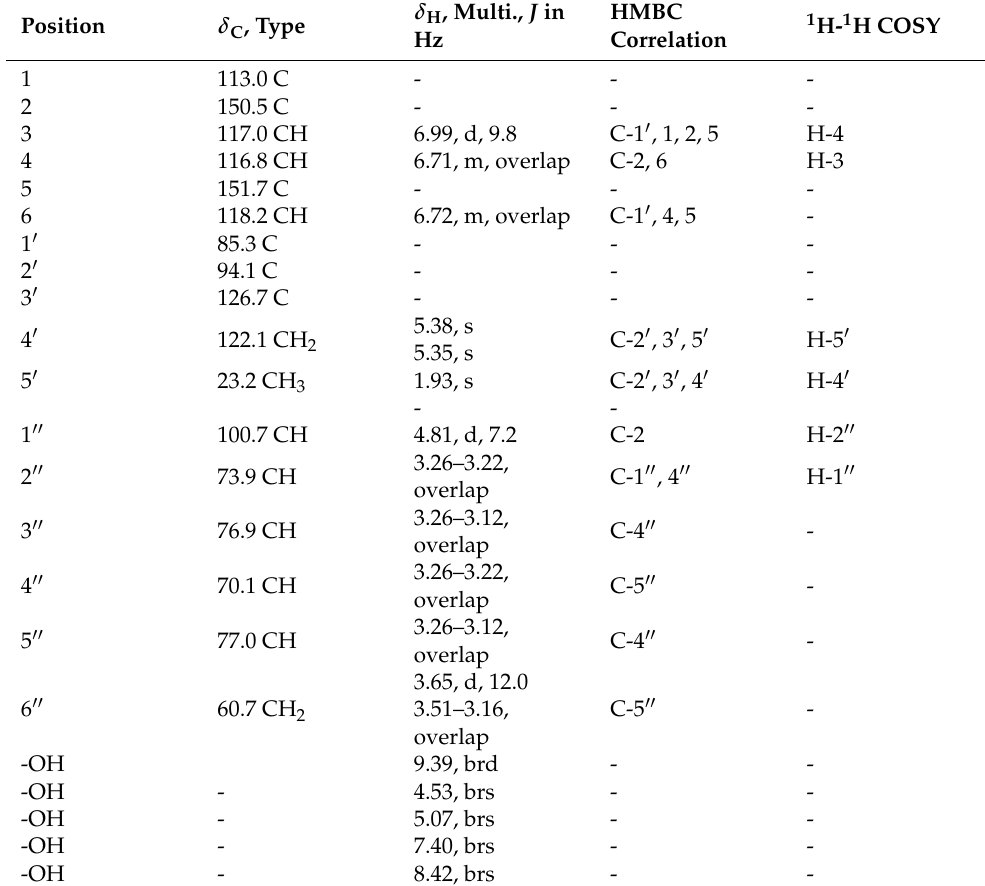
Table 1. 1 H (500 MHz) and 13 C (125 MHz) NMR spectroscopic data for 1 in DMSO- d 6